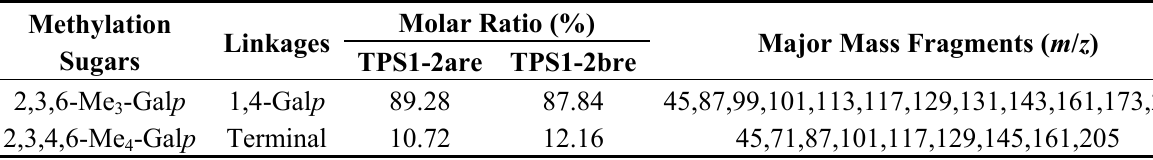
Table 1. GC-MS data for methylation analysis of TPS1-2are and TPS1-2bre, reduced form of TPS1-2a and TPS1-2b,